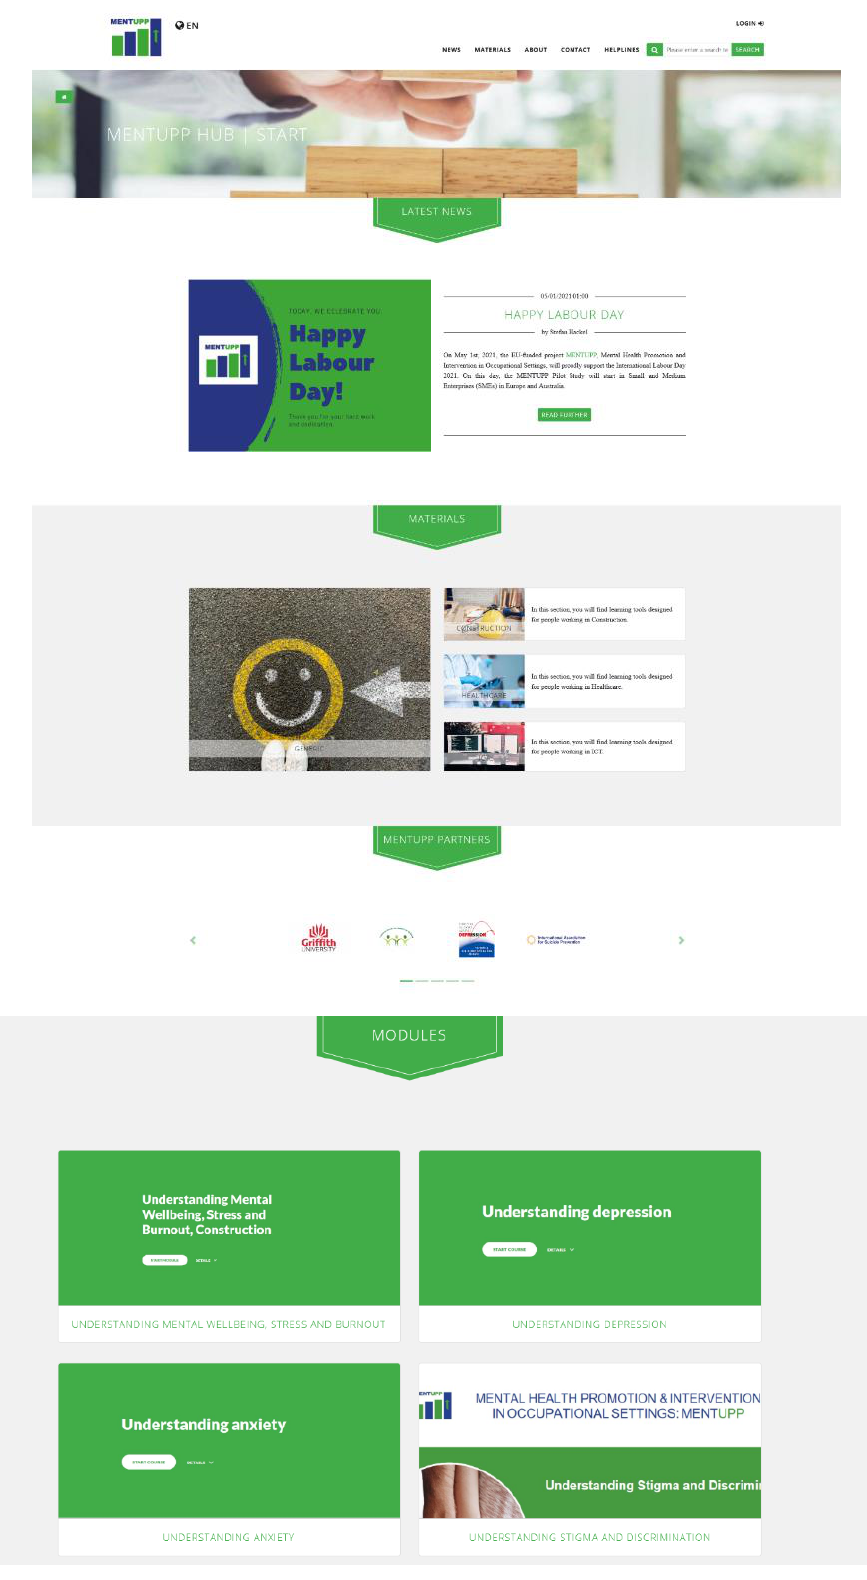
Figure 2. Screenshots of MENTUPP Hub.